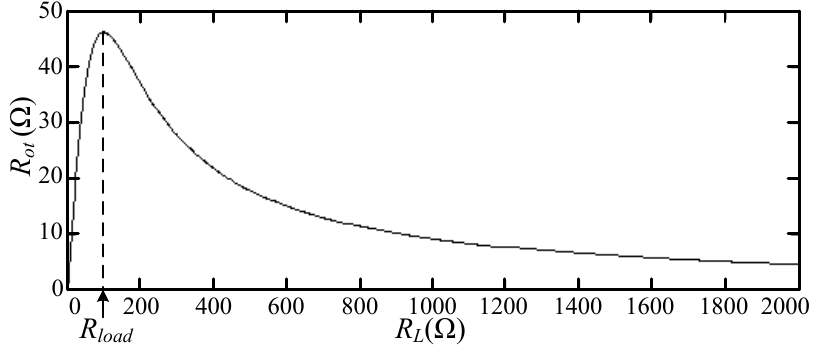
Figure 3. The real part of Z ot varying with the